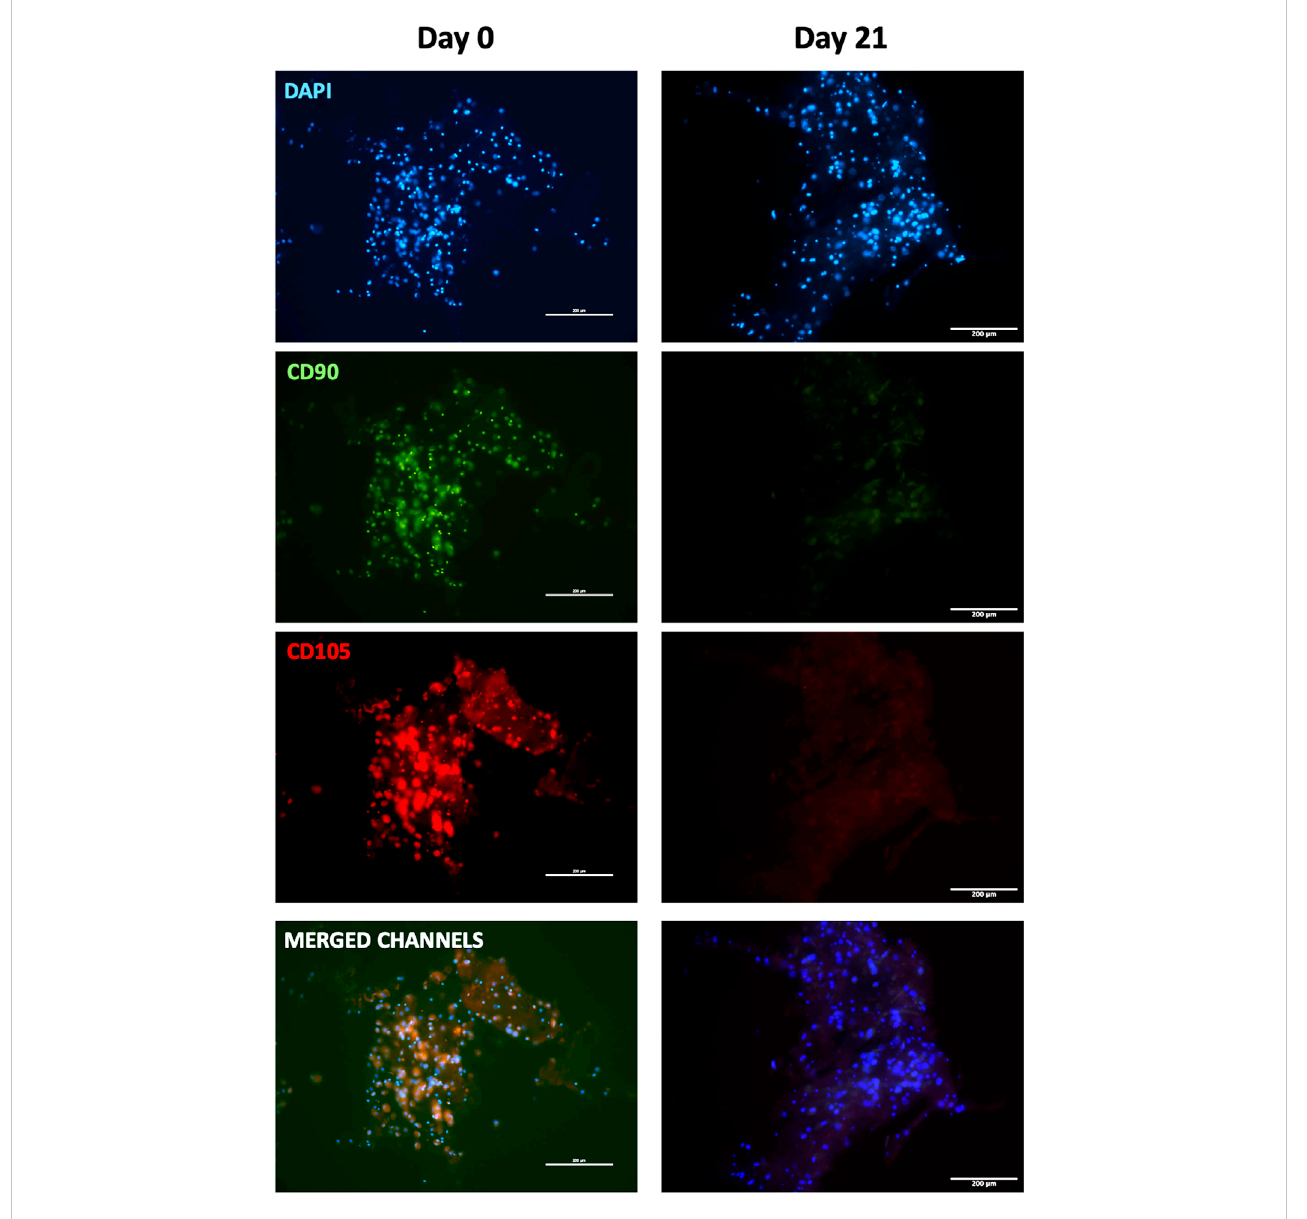
FIGURE 7 Immuno fl uorescence images of 3D fi brin scaffold for stemness markers by IF assay performed staining FITC-conjugated CD90 and PE-conjugated CD105 fi brin scaffolds embedded with h BM-MSCs- h SkMs-PBMCs at day 0 and 21. All images were captured using ×20 magni fi cation, scale bar: 200 µm.